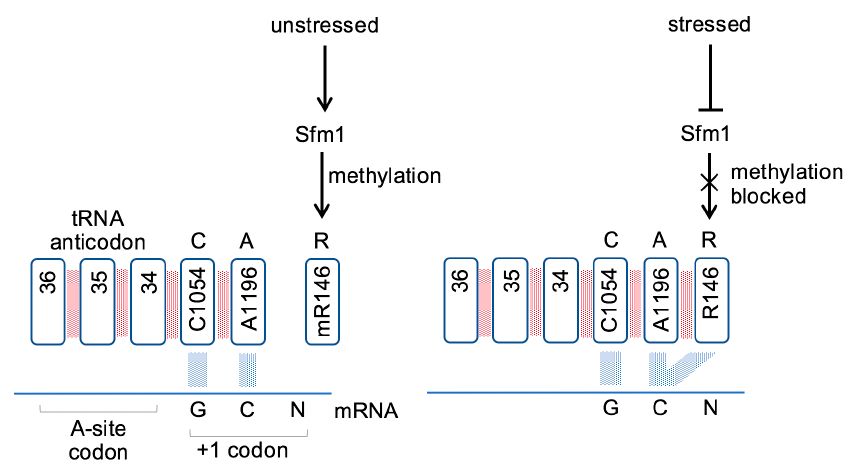
Figure 6. Arginine methylation regulates ribosome CAR function. Methylation of Rps3 R146 is hypothesized to downregulate CAR function by reducing cation-pi stacking of the R146 guanidinium group with A1196 which in turn reduces H-bonding of CAR with the +1 codon next to enter the ribosome A site. Expression of Sfm1, the methyltransferase responsible for R146 methylation, is down regulated in response to stress, promoting CAR integrity and CAR/+1 codon H-bonding.